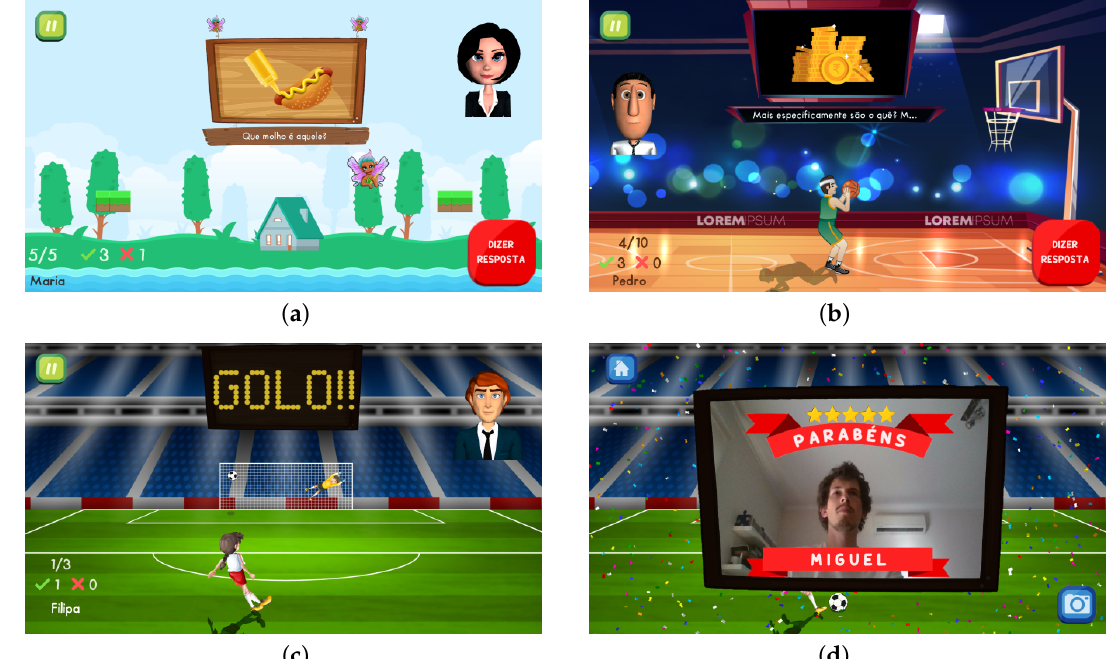
Figure 7. The BioVisualSpeech word naming game. ( a ) Fairy scenario; the host is providing a textual hint. ( b ) Basketball shootout scenario; the host is providing a follow-up hint after synonym answer. ( c ) Penalty shootout scenario; the answer is right. ( d ) Reward